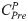
Effect of physical parameters on the FEM used to compensate for the bladder/rectum motion.The X-axis represents the Young’s modulus (in log-scale). The Y-axis represents the Dice similarity coefficient between the pre-treatment, undeformed prostate (CPreP) and the prostate after inducing, and then removing, a synthetic simulation of the bladder and rectum filling (T^2(C˜PostP)).